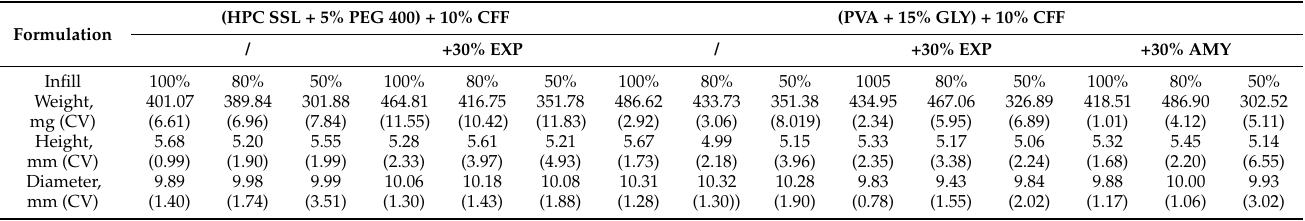
Table 6. Weight and dimension characteristics of HPC SSL- and PVA-based cores printed with different infill percentages.